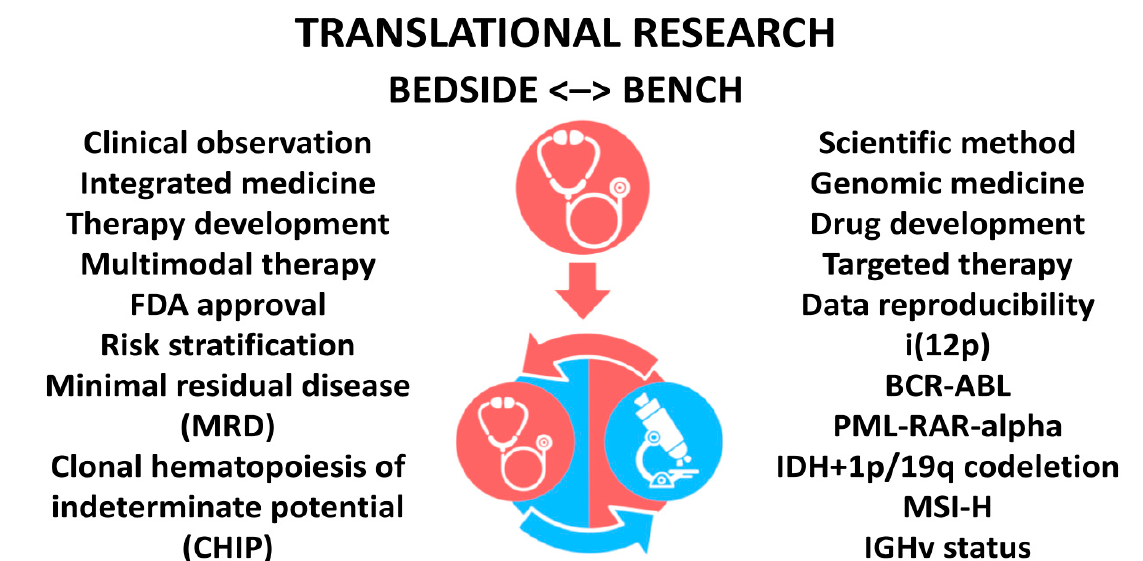
Figure 1. Stem cell theory of cancer and translational research: Biological processes and clinical implications. Illustration by Benjamin Tu.